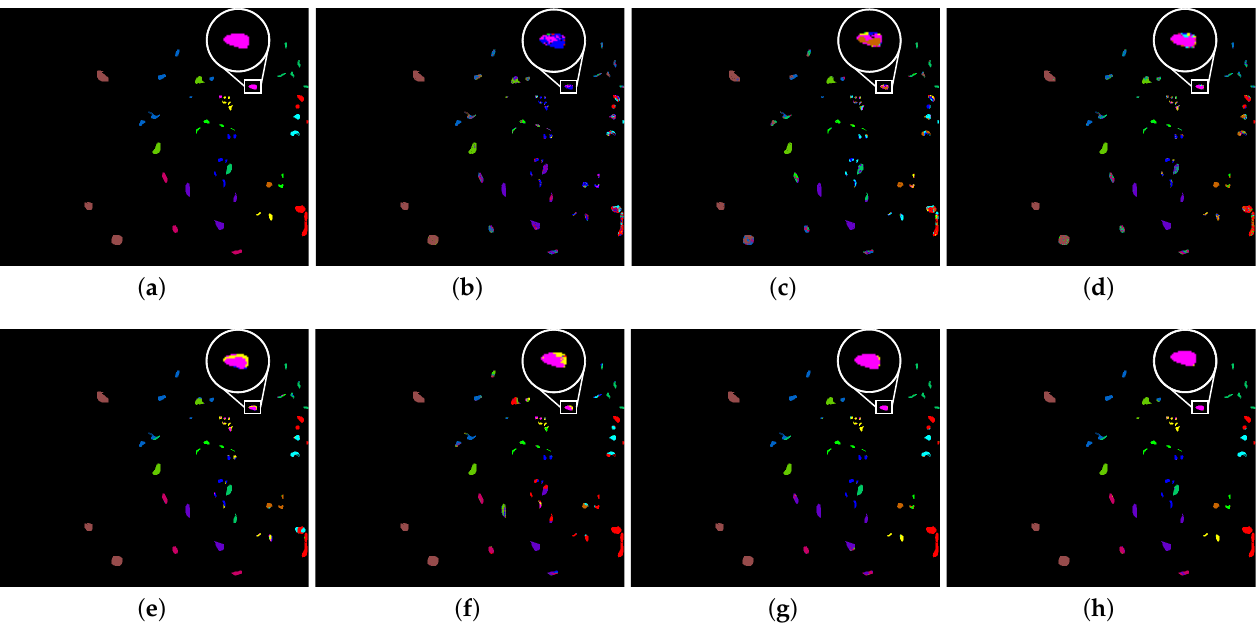
Figure 9. Graph of classification results of KSC dataset. The colored regions are too small to visually distinguish details; therefore, the boxed regions have been enlarged for a clear comparison. ( a ) Ground truth (GT). ( b ) SVM. ( c ) 2DCNN. ( d ) 3DCNN. ( e ) DFSL. ( f ) RN-FSC. ( g ) SSAD. ( h ) SSKD.